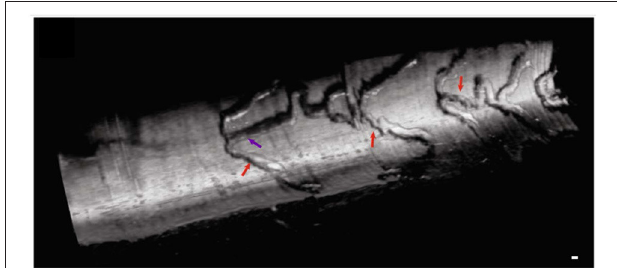
FIGURE 8 | Intravascular 3D- µ OCT of a drug-eluting stent implanted in the atherosclerotic rabbit iliac artery in vivo . The artery was imaged immediately after the stent implantation. Stent struts are denoted by the purple and red arrows. Scale bar, 100 µ m. Figure and capture reprinted with permission from Yin et al.